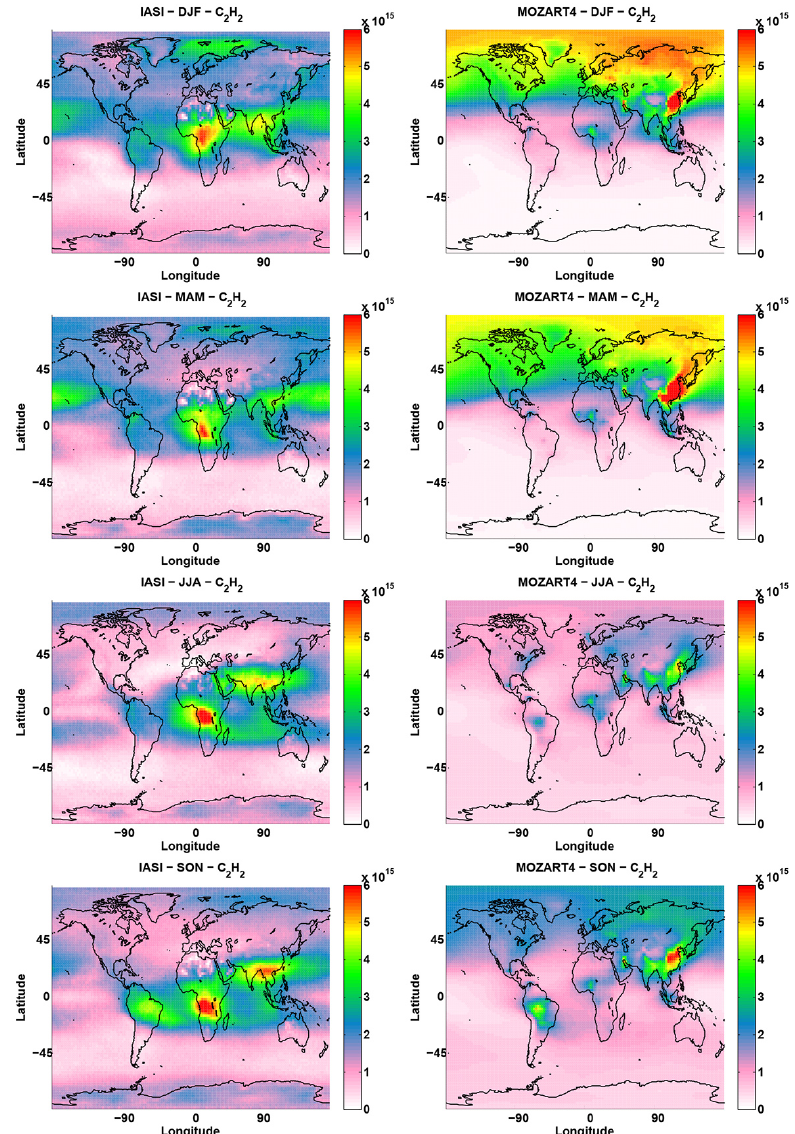
Figure 9. Seasonal distribution of the C 2 H 2 total column (in moleccm − 2 ) as measured by IASI (left panel) and simulated by MOZART-4 (right panel) averaged over the years 2008 to 2010. The IASI global distributions are given with the same horizontal resolution as MOZART- 4 (1.875 ◦ latitude × 2.5 ◦ longitude). DJF represents December–January–February, MAM: March–April–May, JJA: June–July–August, and SON: